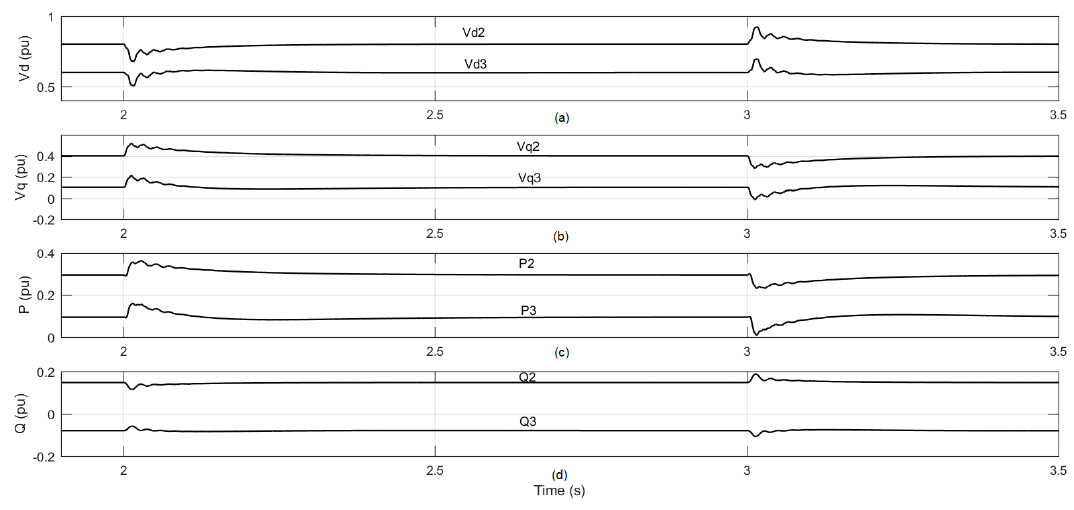
Figure 4. Proposed controllers’ performance of DG 1 as a result of two-step changes in the voltages set point. ( a ) dq-components of the load voltage at point of coupling (PC) 1. ( b , c ) Instantaneous load voltages of PC 1. ( d ) Output active and reactive power of DG 1.